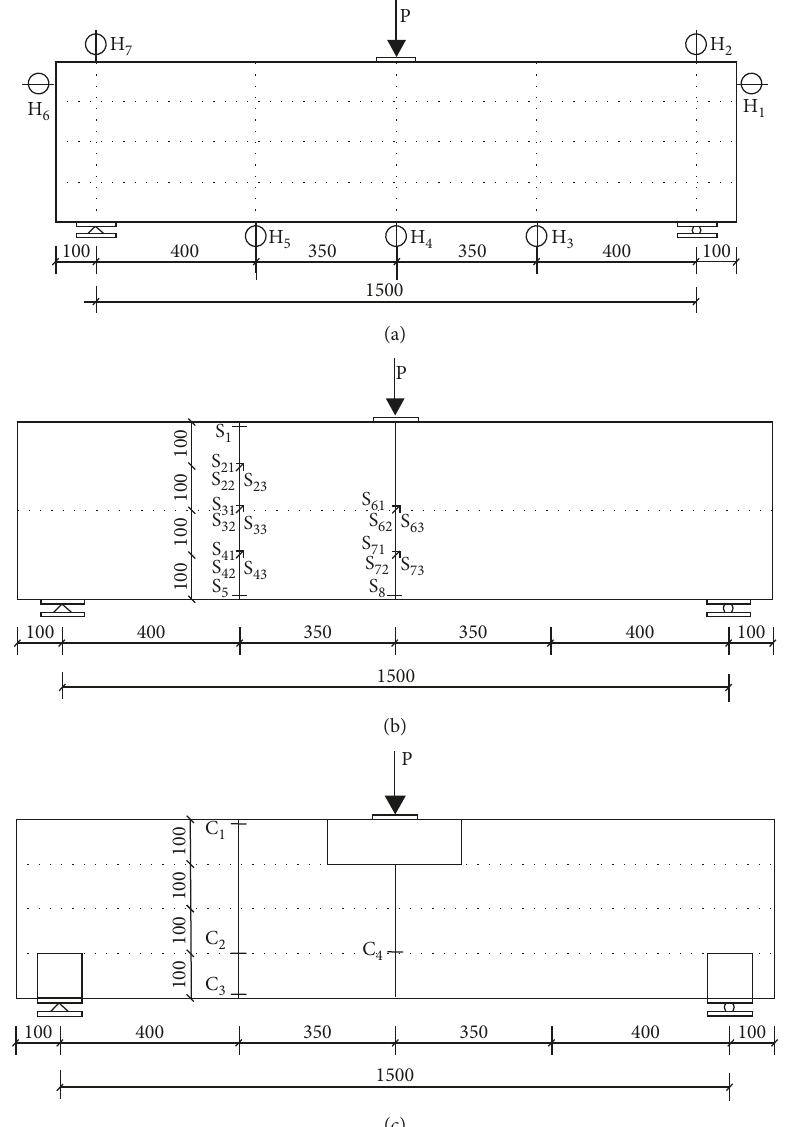
Figure 4: Layout of displacement gauges and strain gauges. (a) Layout of displacement gauges. (b) Layout of strain gauges on steel plate. (c) Layout of strain gauges on concrete